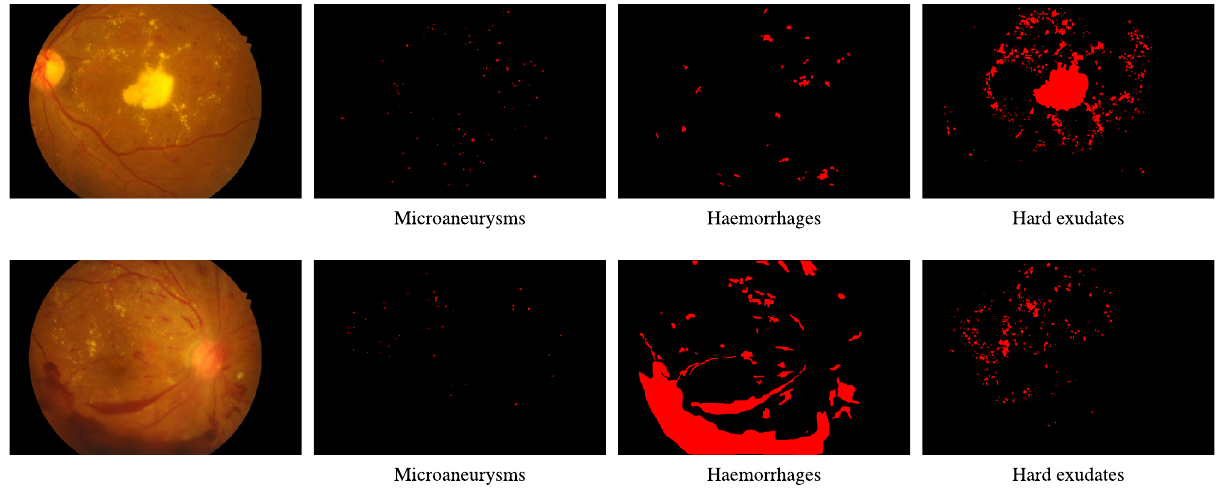
Figure 5. Sample images and their corresponding pixel-level lesion annotations from the IDRiD